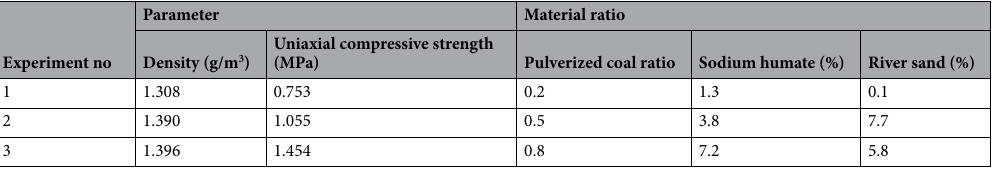
Table 8. Raw material ratio of similar materials.